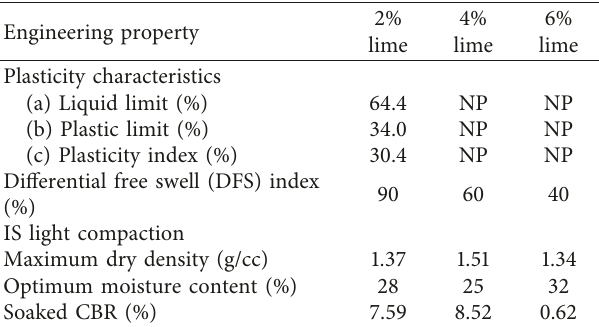
Table 3: Properties of black cotton soil stabilized with